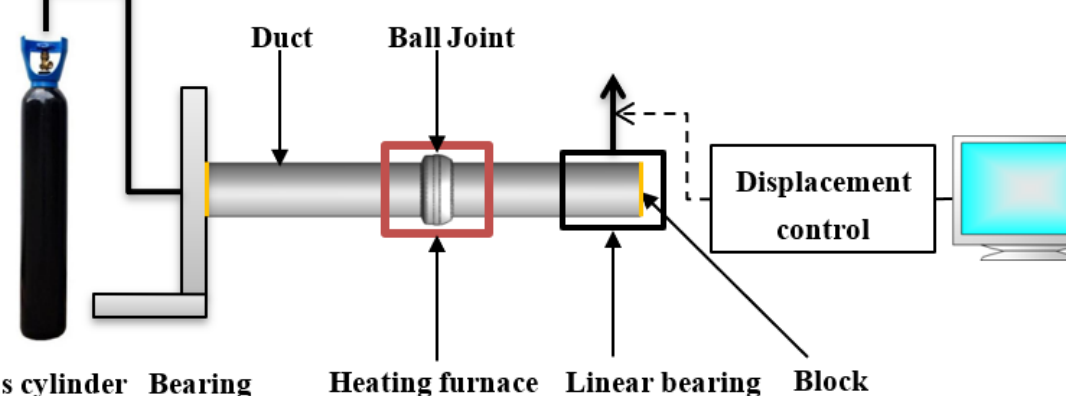
Figure 4. Schematic diagram of the experiment.